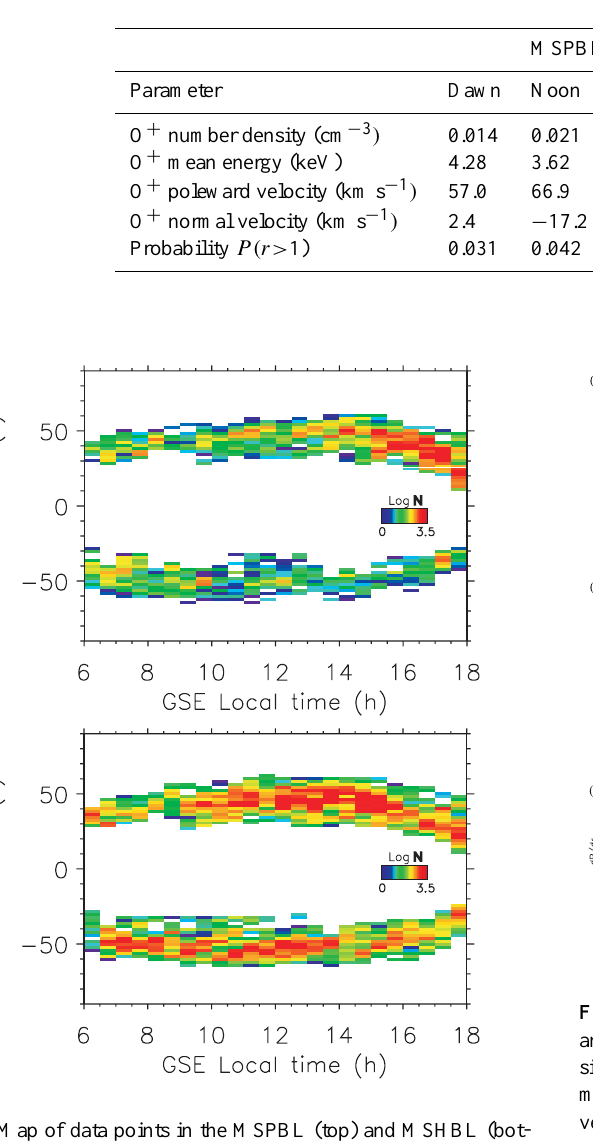
Table 2. List of mean parameters in the dawn, noon and dusk magnetospheric transition layers inferred from the probability density functions of Fig. 10.